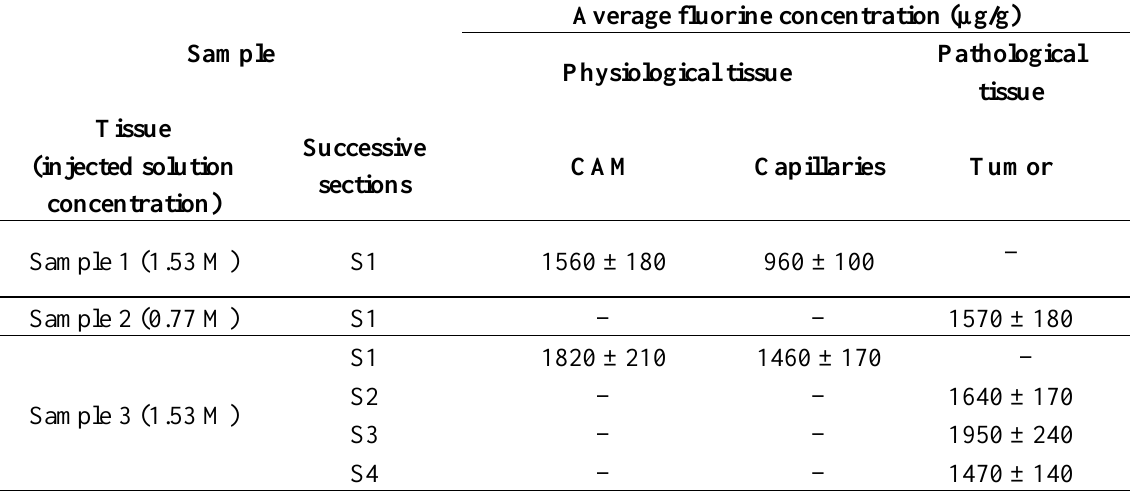
Table 1. Fluorine concentration in normal and tumor tissues exposed to FDG solutions (0.77 and 1.53